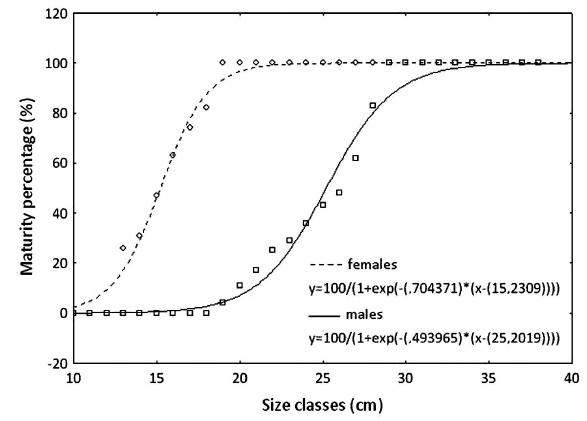
Fig . 5. – Sexual maturity ogive for females and males of Labrus mixtus in the Adriatic Sea.